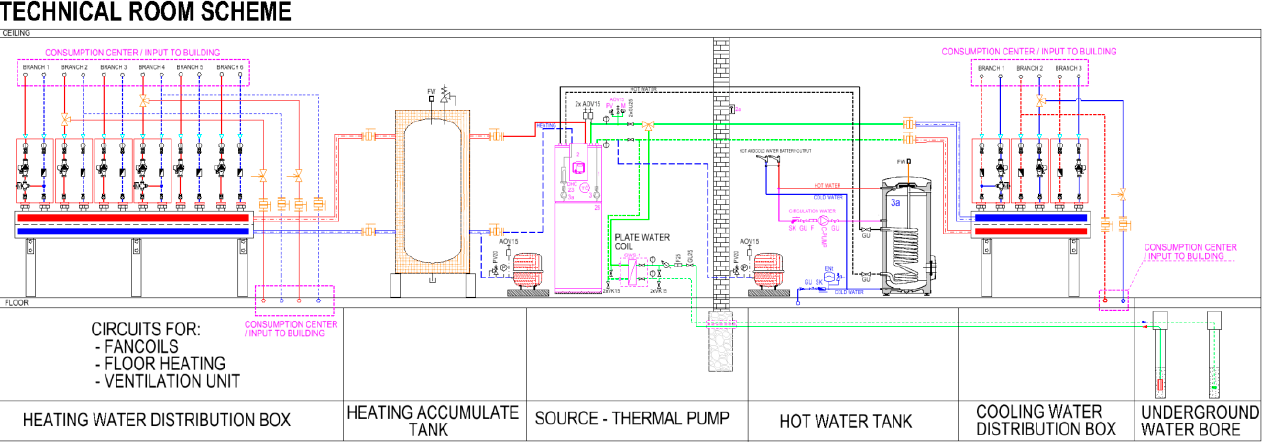
Figure 4. Boiler room scheme.